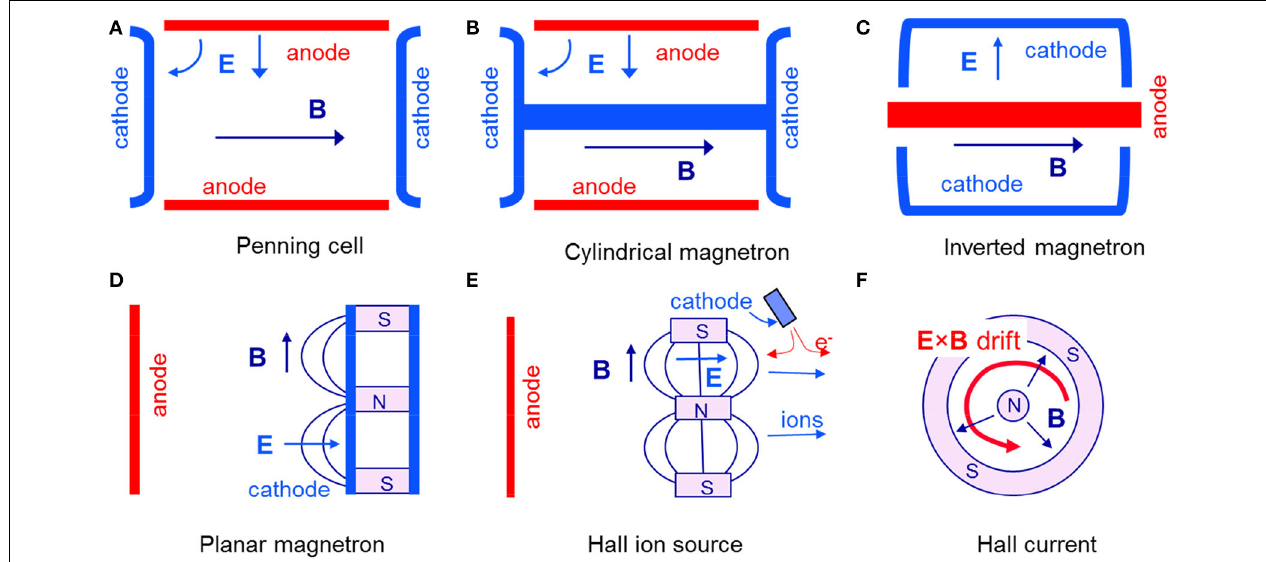
FIGURE 1 | Schematic representation of the geometry of different E × B devices. The devices are cylindrically symmetric (horizontal axis). (A–C) : axial B, radial E; (D–F) : axial E, radial B. (E) does not represent a real device but shows the principle of Hall ion sources which are similar to planar magnetrons (D) but with an electron emitting cathode instead